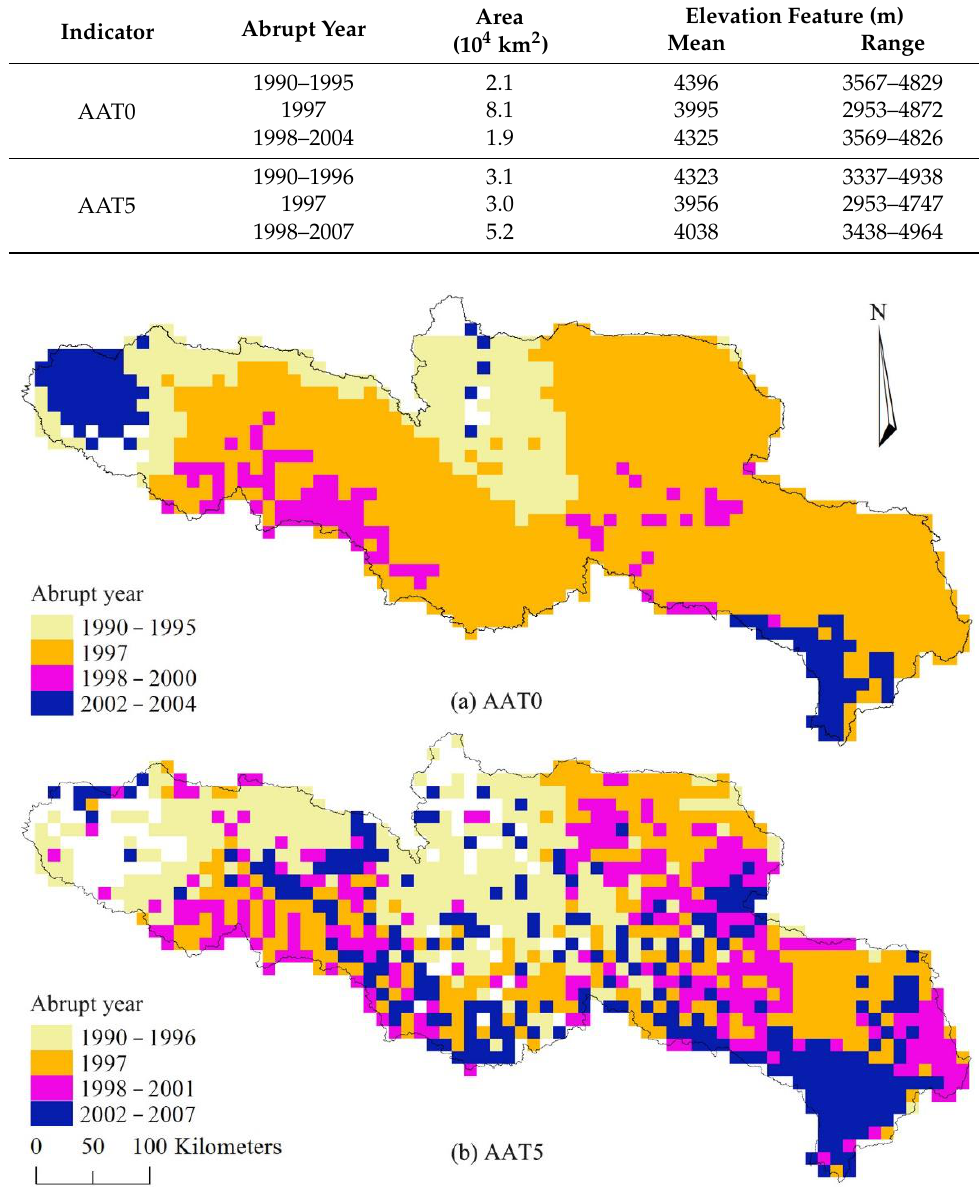
Table 9. The area and elevation features of the abrupt year of the AAT.